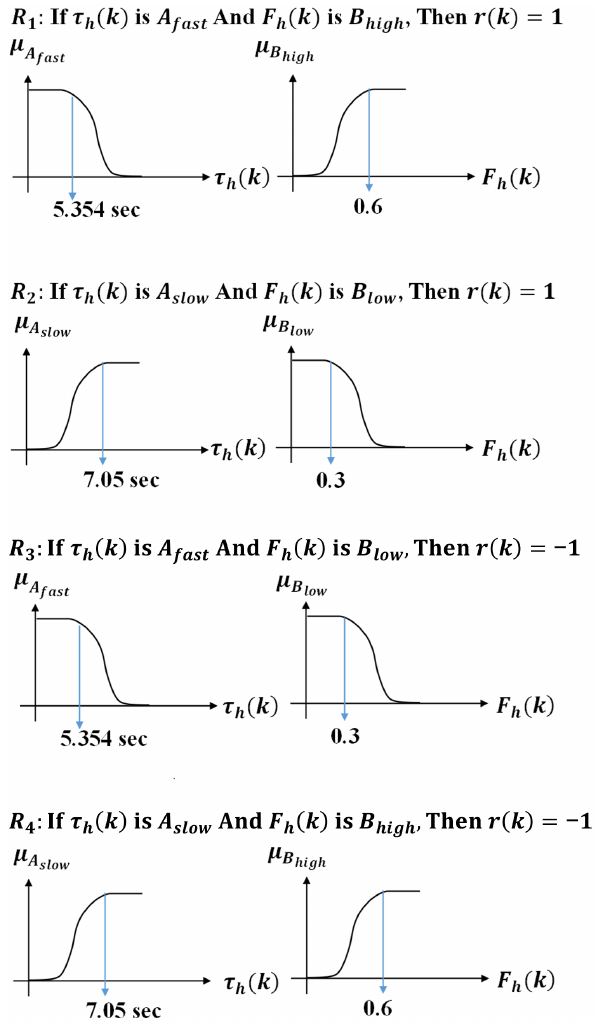
Figure 3. Four rules of the fuzzy neural